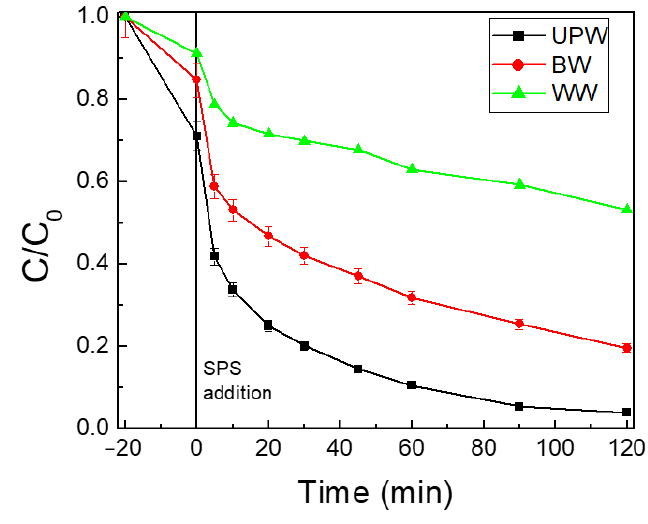
Figure 12. Effect of water matrix on 500 mg/L SMX degradation with 100 mg/L biochar (RHB 850) and 500 mg/L SPS at pH = 5.6.